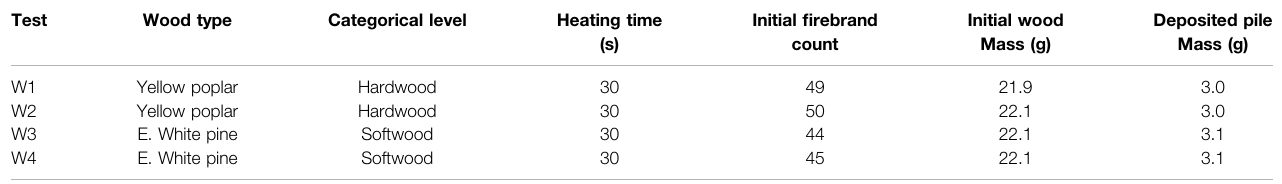
TABLE3| Testmatrixusedtoassesstheimpactof fi rebrandwoodtypefactorontheheat fl uxfrom fi rebrandpiles.Firebranddiameter9.5 mm,length12.5 mm,andMC0% with wind speed 2.0 m/s.